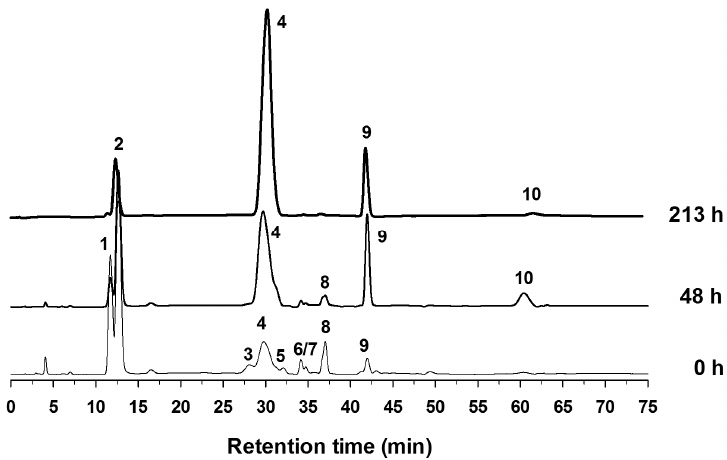
Figure 6. HPAEC ‐ PAD analysis of the PBR outlet at various operation times (0, 48 and 213 h). Peaks: Figure 6. HPAEC-PAD analysis of the PBR outlet at various operation times (0, 48 and (1) Galactose; (2) Glucose; (3) Allolactose; (4) Lactose; (5) 3 ‐ Galactobiose; (6) 4 ‐ Galactobiose; (7) 6 ′‐ 213 h). Galactosyl ‐ lactose; (8) Gal ‐β (1 → 3) ‐ Glc; (9) 4 ′‐ Galactosyl ‐ lactose; (10) Gal ‐β (1 → 4) ‐ Gal ‐β (1 → 4) ‐ Gal ‐ β (1 → 4) ‐ Glc.